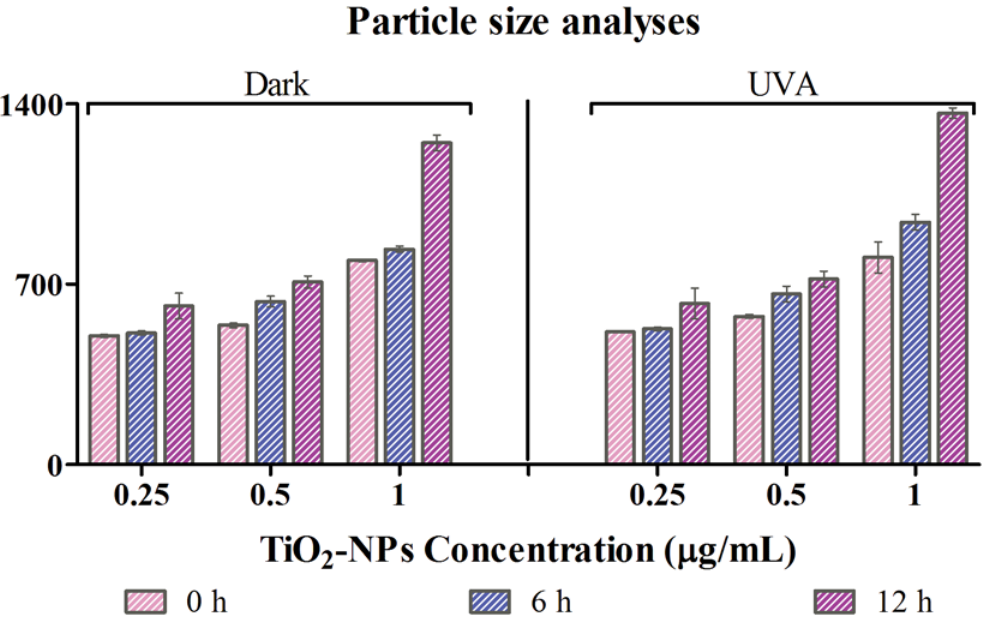
Fig 1. Stability of TiO 2 NPs: With dynamic light scattering technique, size of the nanoparticles in waste water medium was analyzed. Values reported are at 0h, 6h and 12 h under dark and UVA conditions (350 nm, 18w and intensity of 1mW/cm 2 ) for 0.25, 0.5 and 1 μ g/ml of TiO 2 NPs.